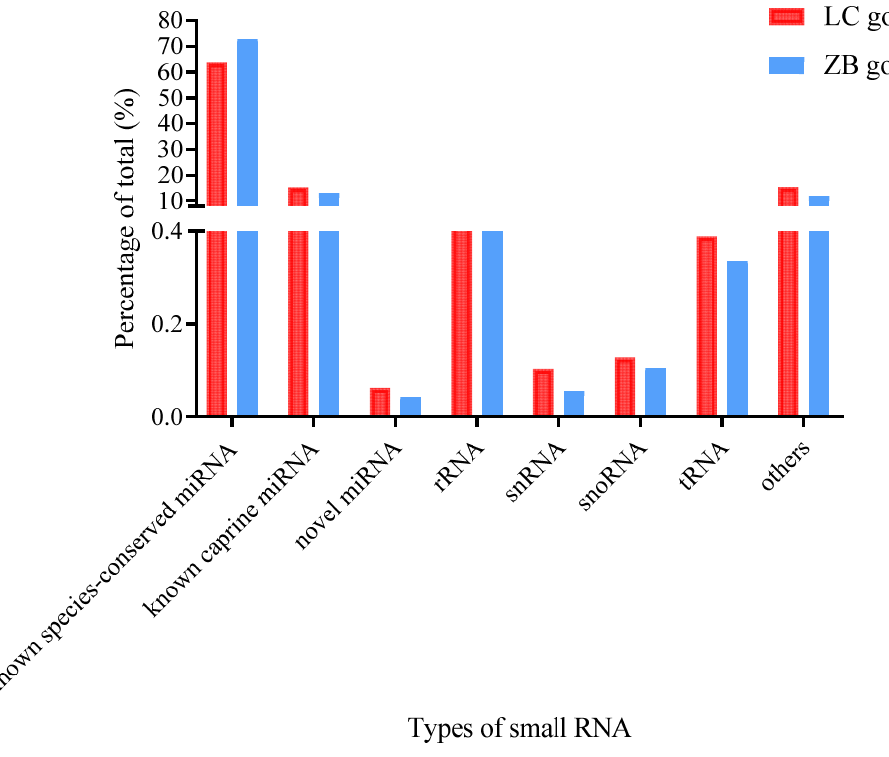
Figure 1. The proportion of small RNAs in the skin tissue samples of Liaoning cashmere (LC) goats and Ziwuling black (ZB) goats.